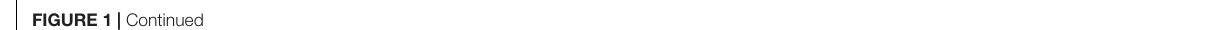
FIGURE 1 | Continued HT29/LOVO cells cultured in G vs. 0 µ M DOX in HT29/LOVO cells cultured in G; •• p < 0.001 0.05, 0.1, 0.5, 1, 2.5, 5, and 10 µ M DOX in HT29/LOVO cells cultured in HG, respectively, vs. 0.05, 0.1, 0.5, 1, 2.5, 5, and 10 µ M DOX in HT29/LOVO cells cultured in G. (B) Cells were left untreated or incubated for 48 h before analysis with 0.5 µ M and 1 µ M of DOX (B,F) or for 24 h with 5 µ M and 10 µ M of DOX (D,H) , then the LDH activity was measured. Extracellular LDH activity was calculated as total (intracellular and extracellular) LDH activity in the dish. Measurements ( n = 8) were performed in duplicate. ∗∗∗ p < 0.0001 0.5, 1, 5, and 10 µ M DOX in HT29/LOVO cells cultured in G vs. 0 µ M DOX in HT29/LOVO cells cultured in G; ••• p < 0.0001 0.5, 1, 5, and 10 µ M DOX in HT29/LOVO cells cultured in HG vs. 0 µ M DOX in HT29/LOVO cells cultured in HG; ◦◦ p < 0.001 1 µ M DOX in HT29/LOVO cells cultured in HG vs. 0 µ M DOX in HT29/LOVO cells cultured in HG; ◦◦ p < 0.001 and ◦ p < 0.002, respectively, 0.5, 1, 5, and 10 µ M DOX in HT29/LOVO cells cultured in HG vs. 0.5, 1, 5, and 10 µ M DOX in HT29/LOVO cells cultured